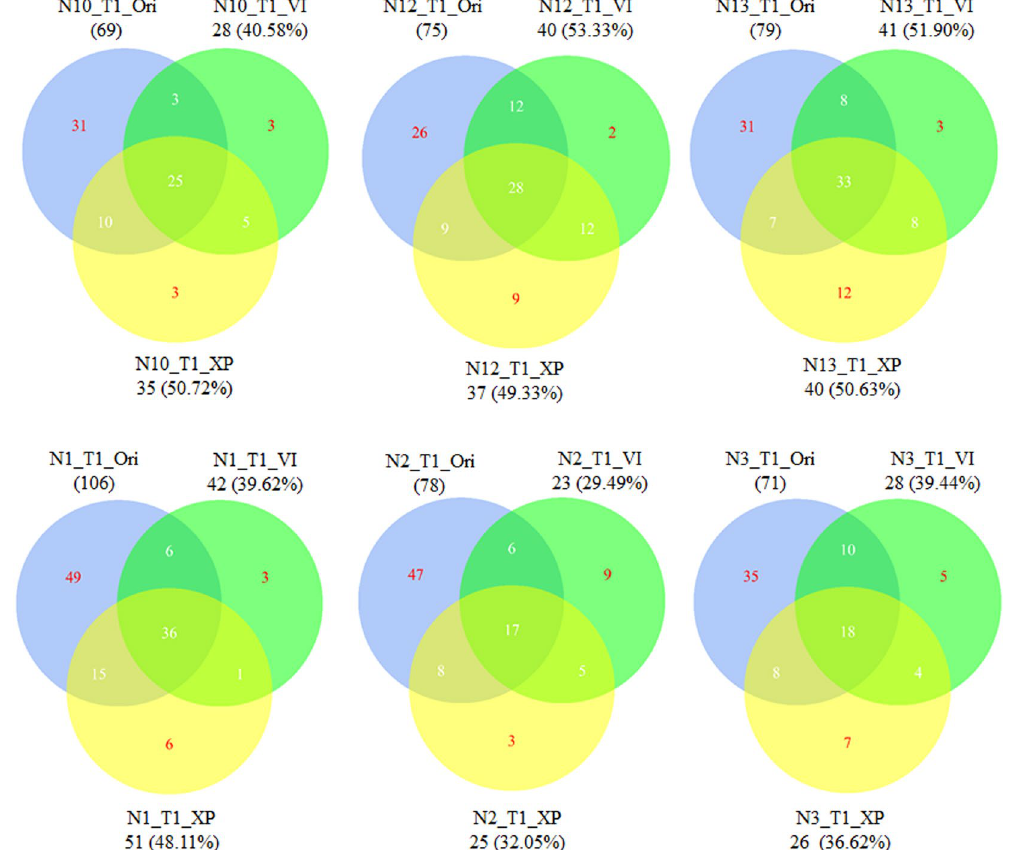
Figure 4. Analyses of the number of genera cultured in chemostats. 16 S rRNA gene high-through put sequencing data was classified using the rdp classifier method and silva123 database. At the genus level, Venn diagrams were then drawn by R